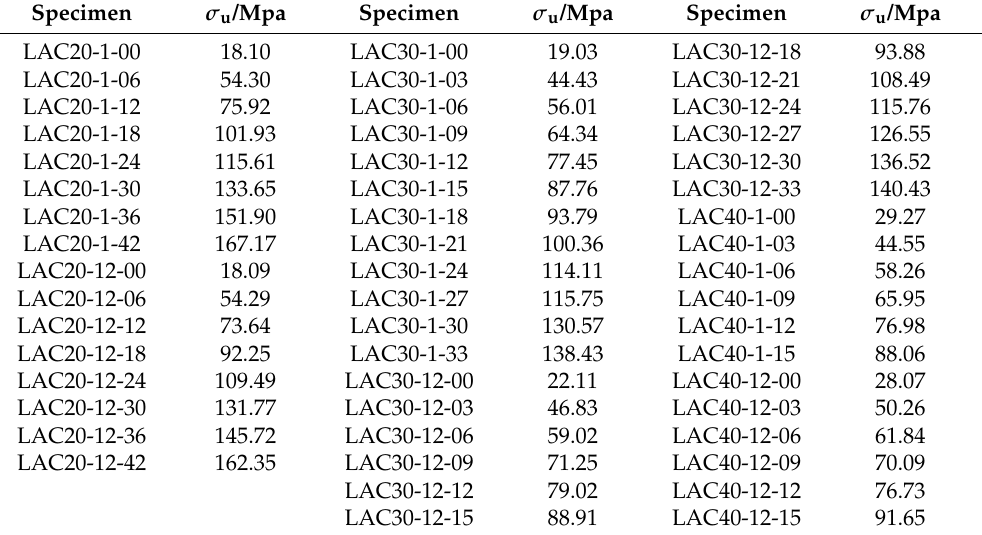
Table 4. Mechanical properties of test specimens.